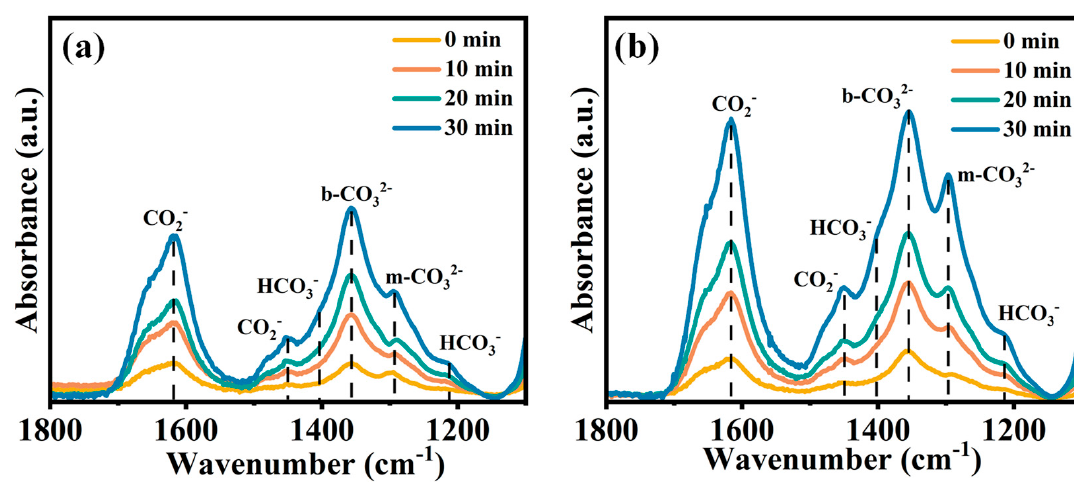
Figure 7. In situ FTIR spectra of ( a ) SnIn 4 S 8 and ( b ) Cu 10 Au 1 -SnIn 4 S 8 .